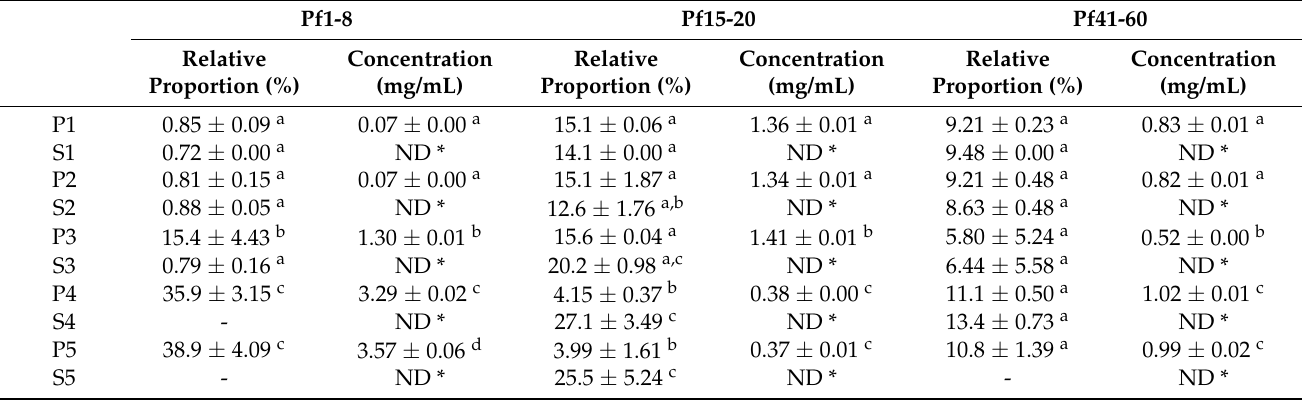
Table 2. Relative proportions and concentrations of Pf1-8, Pf15-20, and Pf41-60 in pellets (P1 to P5) and supernatants (S1 to S5) recovered after each wash step.